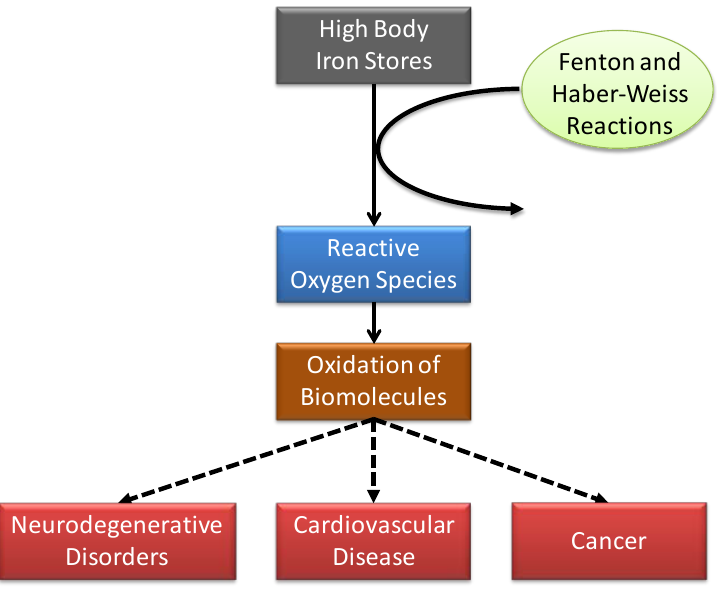
Figure 1. Oxidative stress due to high body iron